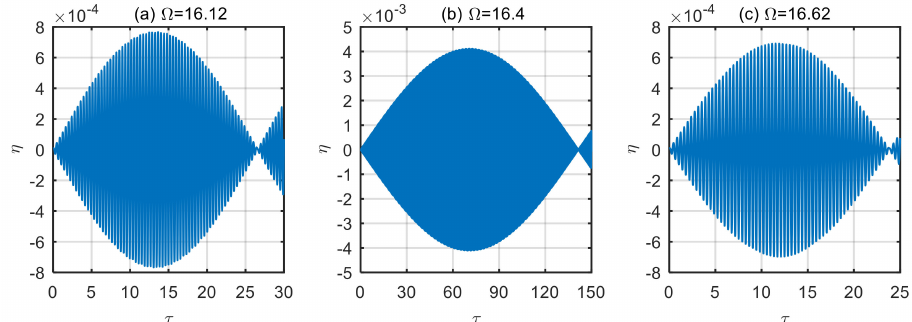
Figure 8. Bifurcation diagram of microtube displacement with dimensionless frequency of the excitation loads. ( a ) u = 1; ( b ) u = 4; ( c ) u = 6; ( d ) u = 8.